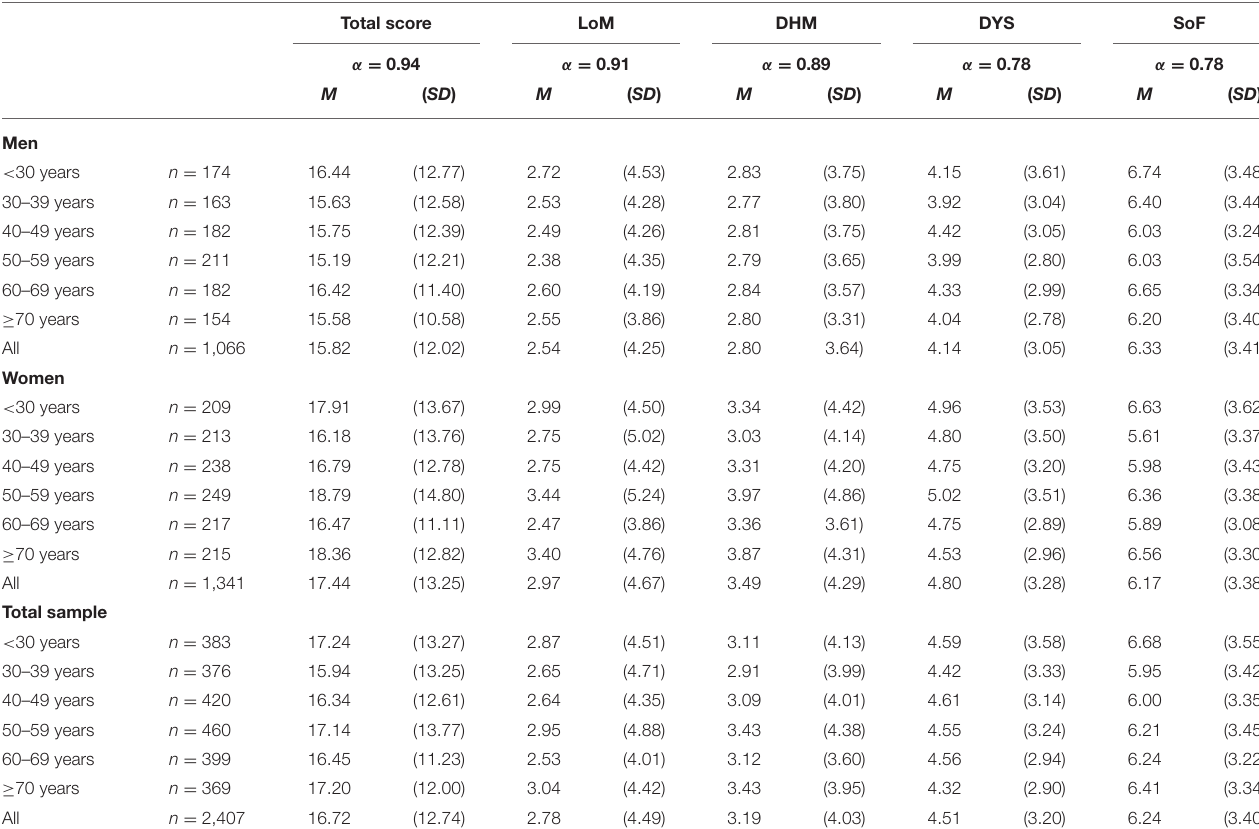
TABLE 3 | Mean scores and standard deviations of the DS-I separated by sex and age